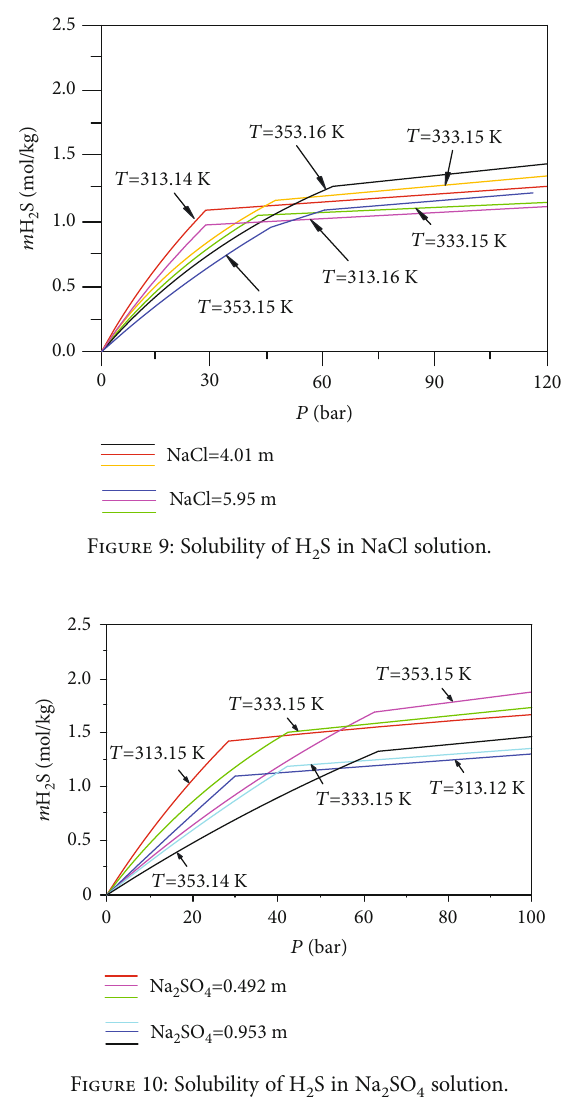
S in Na SO 2 2 4